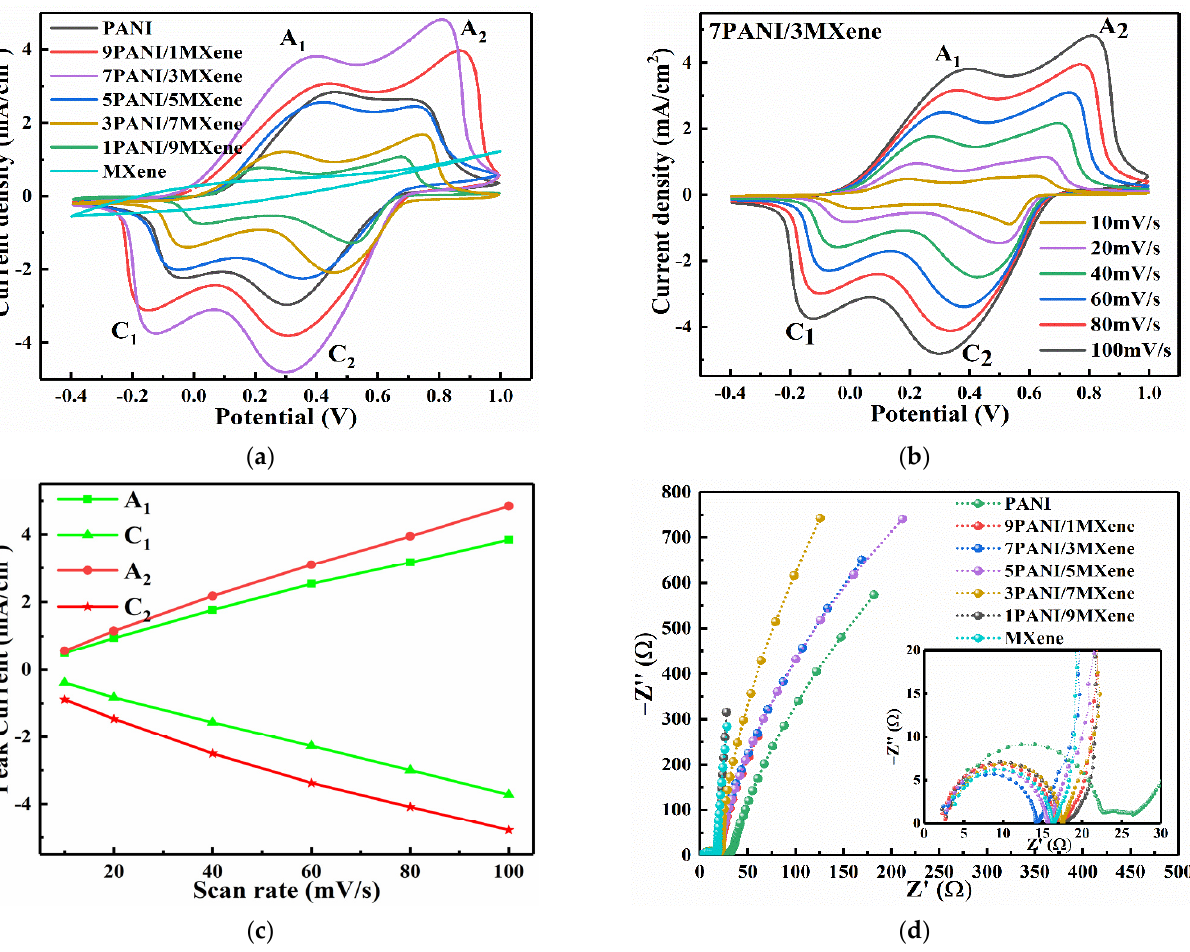
Figure 5. ( a ) CV curves of PANI/MXene hybrids electrodes with different mass ratios at the scan rate of 100 mV/s; ( b ) CV curves of the 7PANI/3PANI hybrids electrode at different scan rates; ( c ) Relationships of peak current density vs. potential scan rate; ( d ) Nyquist plots of PANI/MXene hybrids electrodes with different mass ratios in 0.1 M HCl in the frequency range of 10 − 2 –10 5 Hz.